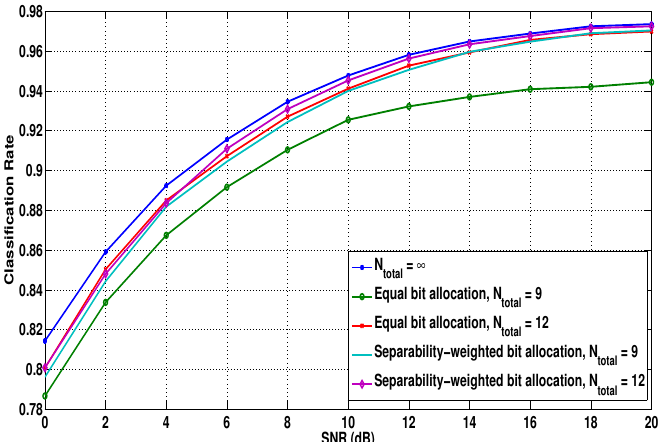
Figure 5. Average recognition rates when PVQ is applied and the path-loss components experienced by each node’s signal are significantly